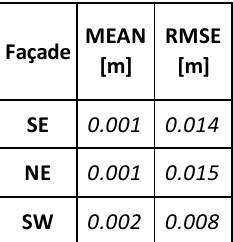
Figure 12. Comparison between the north-east photogrammetric mesh and TLS point cloud.